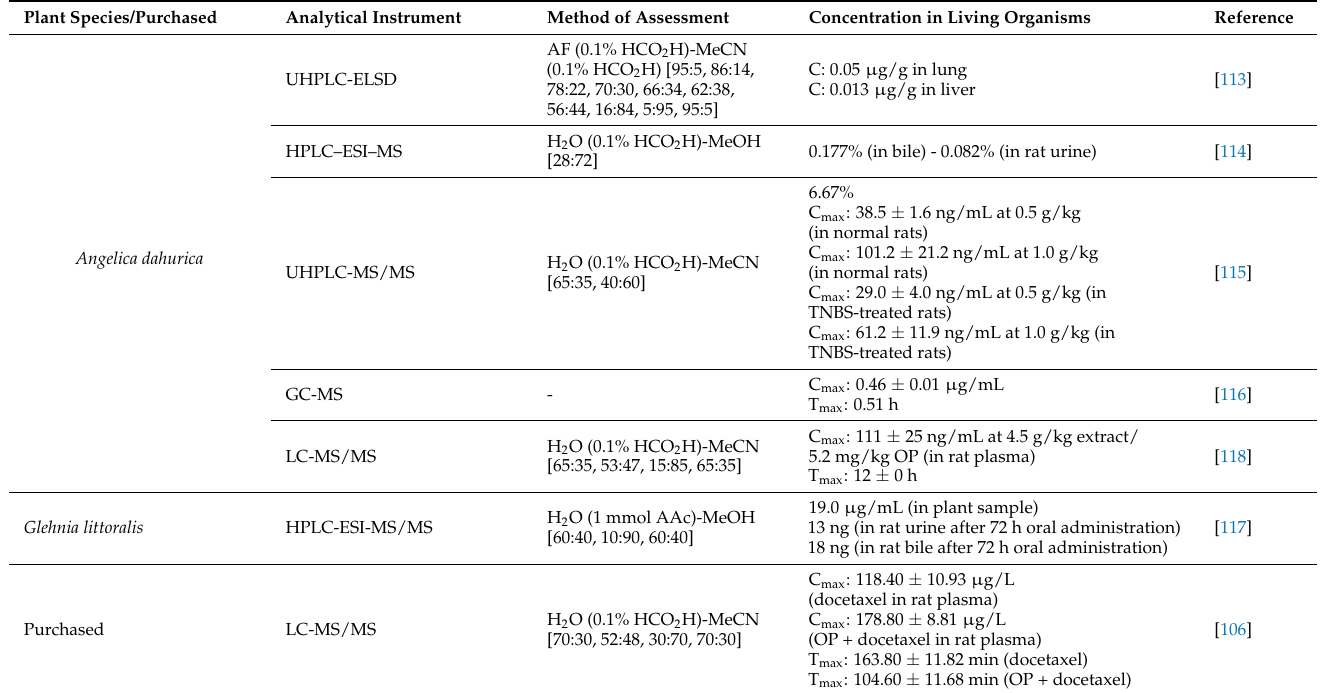
Table 3. Pharmacokinetic studies of